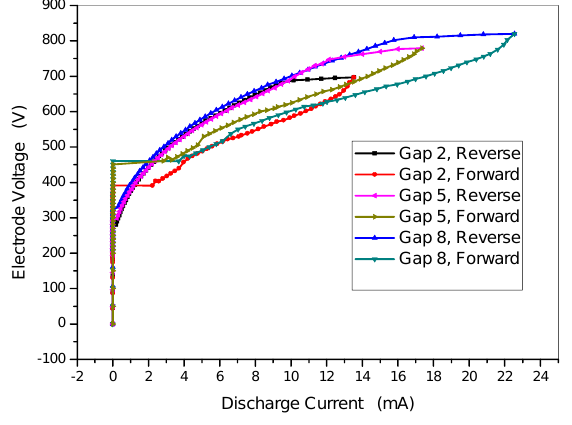
Figure 6: V − I characteristic and hysteresis for different